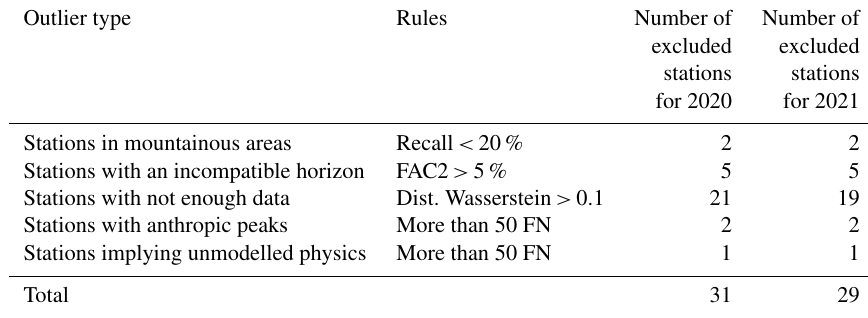
Figure 11. Observed and simulated ambient gamma dose rates at the Rodez station. (a) In June and July 2021. (b) The 24 June 2021. Table 2. Summary of the outlier